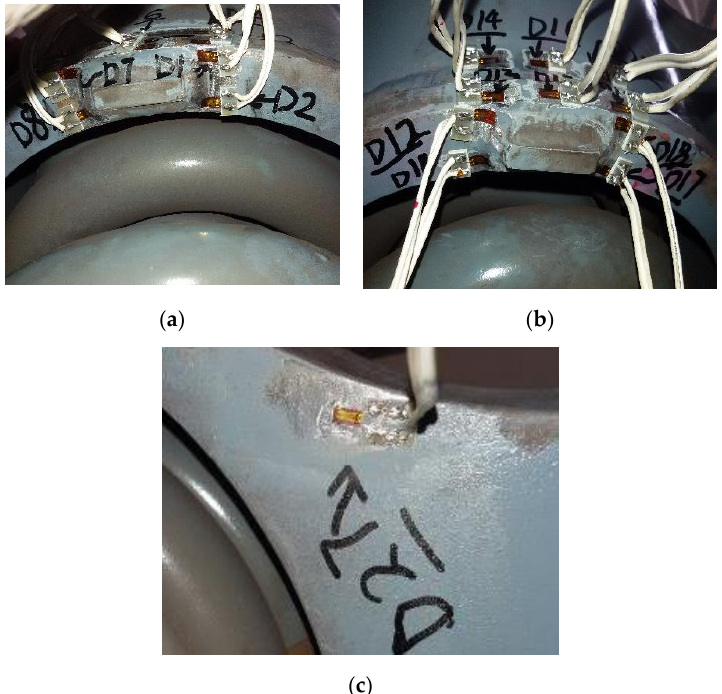
Figure 5. Strain gauge tested points around the positioning block: ( a ) D02; ( b ) D11 and D17; ( c ) D27.